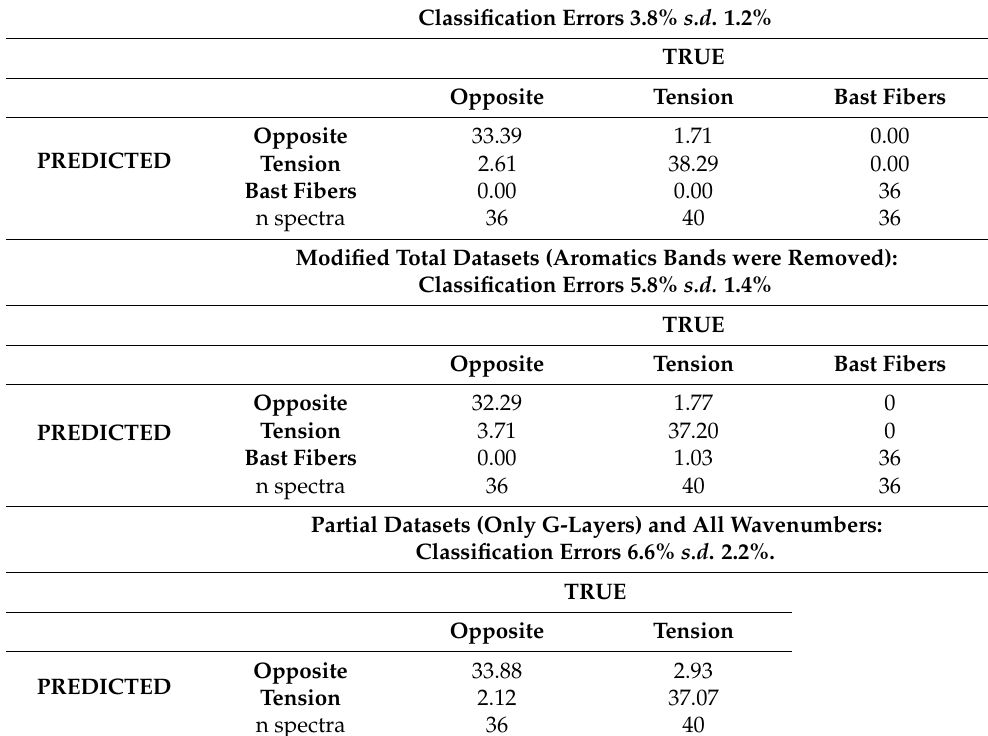
Table 1. Mean confusion matrices of 100 double cross validation PLS-DA detailing classification results on the three Raman datasets. The number of spectra tested was 36, 40 and 36 for opposite, tension and bast fibers, respectively. Numbers are the absolute numbers of classifications (averaged over the 100 iterations). Total Datasets and All